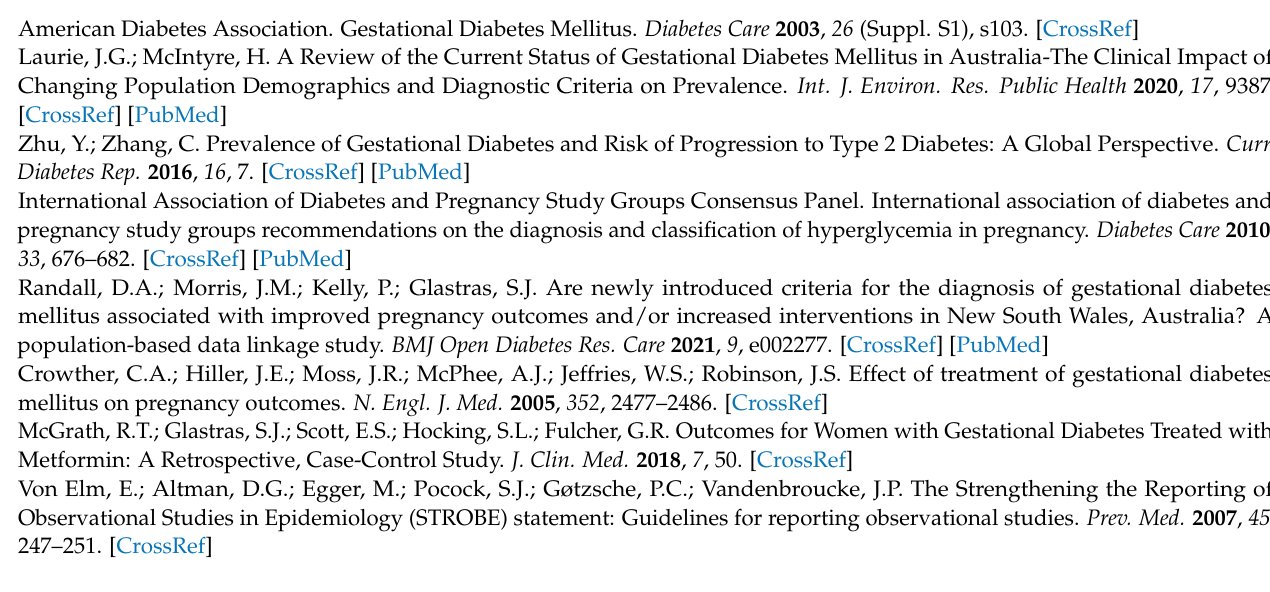
categories; Table S3: GDM diagnostic group and third trimester foetal ultrasound; Table S4: Hazard ratio for outcomes by diagnostic